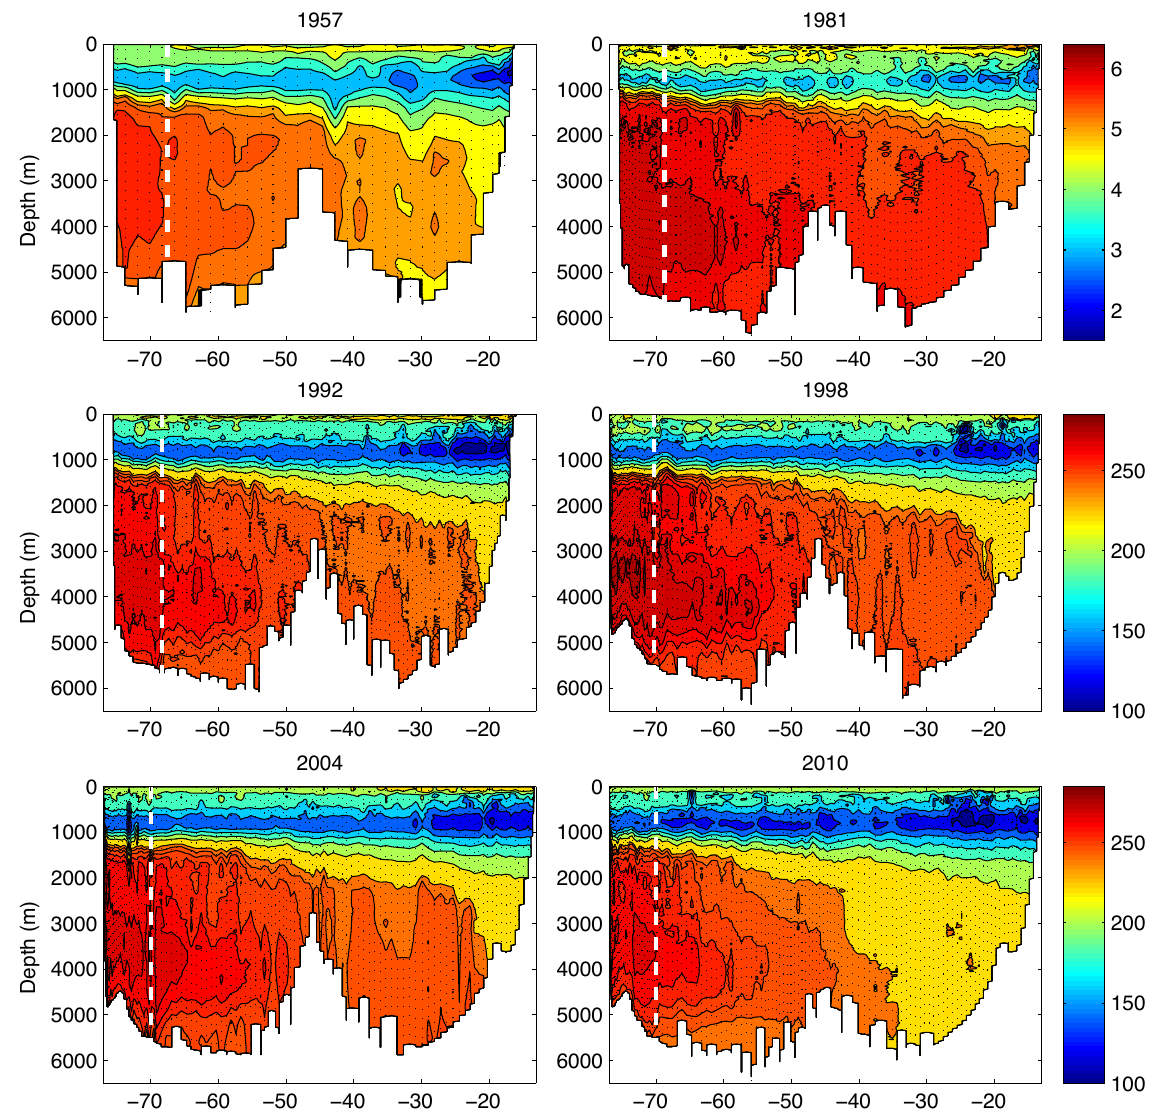
Fig. 3. Oxygen concentrations across 25 ◦ N for the 1957, 1981, 1992, 1998, 2004 and 2010 hydrographic sections (following Longworth, 2007). Oxygen concentrations for the 1957 and 1981 sections (top) are given in mll − 1 and share the same colour scale; contour intervals change from 0.5mll − 1 to 0.2mll − 1 at concentrations above 5mll − 1 . Oxygen concentrations for the later sections are given in µmolkg − 1 and share the same colour scale; contour intervals change from 20µmolkg − 1 to 5µmolkg − 1 above 240µmolkg − 1 . The transition between the western boundary region and mid-ocean is shown as a white dotted line, station positions are shown as black dotted lines.